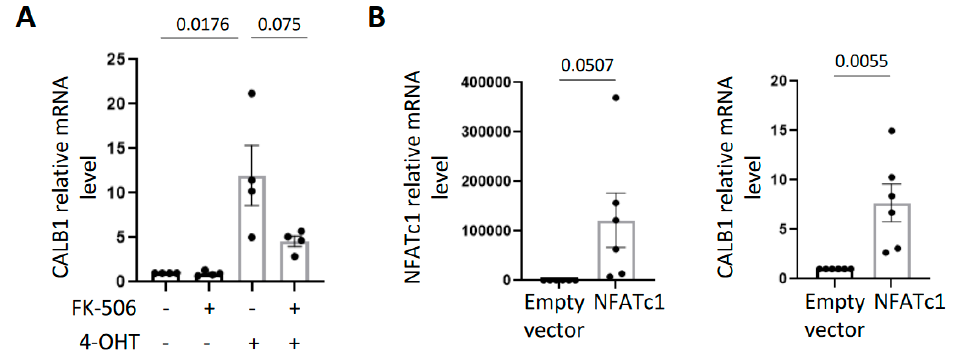
Figure 3. The calcium-dependent calcineurin/NFAT pathway induces CALB1 expression upon oncogene activation in HMECT. ( A ) CALB1 mRNA level was measured by RT-qPCR in HMECT overexpressing 4-OHT-inducible Mek:ER and treated (+) or not ( − ) with FK-506, a calcineurin inhibitor (treated every day with 2 µM during six days), or/and with 4-OHT (100 nM). The first three days, cells were co-treated with 4-OHT and FK-506 (first treatment 4 h prior 4-OHT), and the three last days only with FK-506. Mean +/ − SEM of four independent experiments are shown. An unpaired t -test was performed and p -value is indicated. ( B ) NFATc1 ( left panel) and CALB1 ( right panel) mRNA levels were measured by RT-qPCR in HMECT 24 h after infection with a vector encoding NFATc1 or control empty vector. Mean +/ − SEM of six independent experiments are shown. Unpaired t -tests were performed, and p -values are indicated.